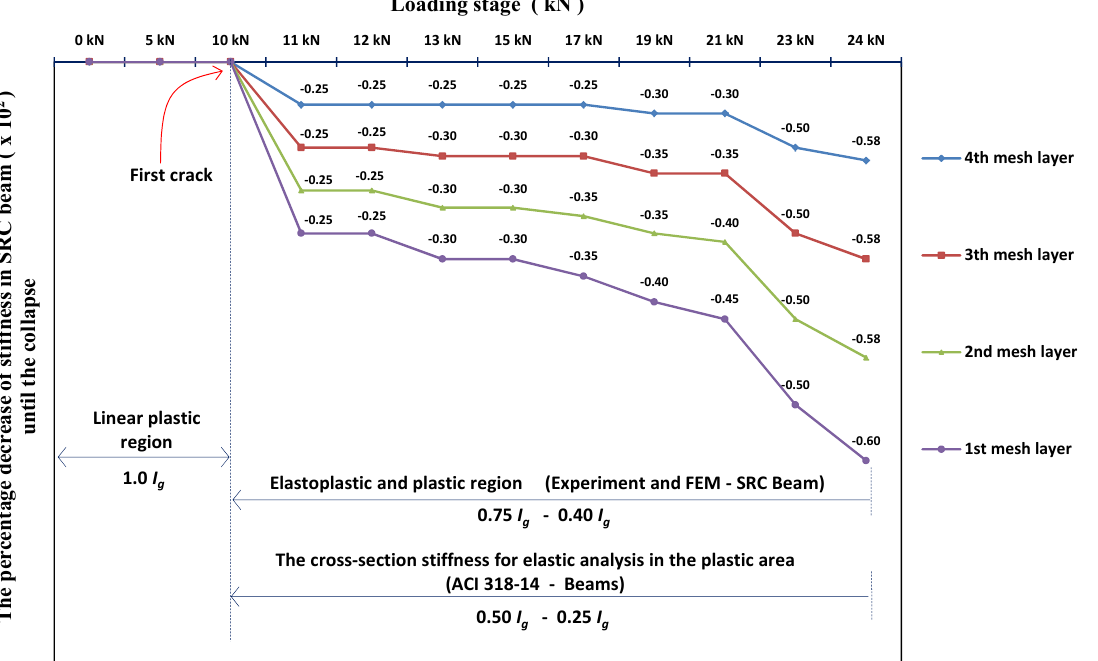
ff ness of SRC beam cross-section in the span Figure 22. Decreased stiffness of SRC beam cross-section in the span middle. Figure 22. Decreased sti